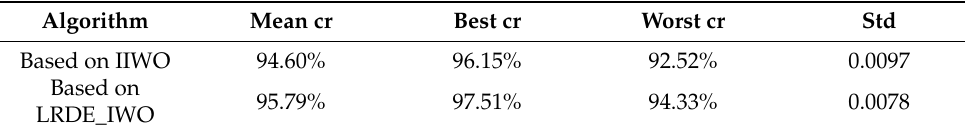
Figure 11. Node distribution optimized by IIWO and LRDE_IWO. Table 7. Comparison of the optimized coverage results of IIWO and LRDE_IWO.